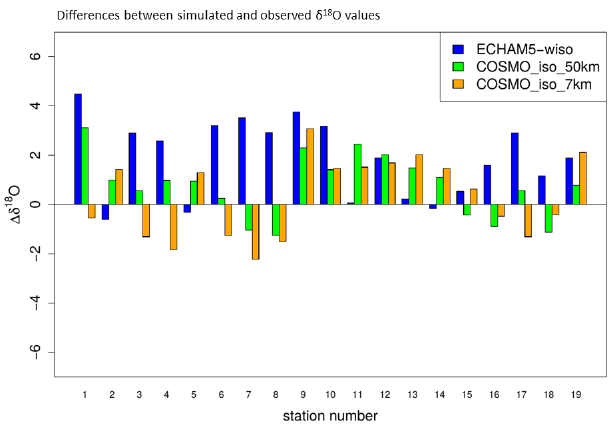
Figure 4. Differences ( (cid:49) ) between simulated and observed δ 18 O values (model minus observation) for the model results of ECHAM5-wiso, COSMO_iso_50km, and COSMO_iso_7km and snow pit samples and top core samples from ice cores from Greenland (averaging periods: COSMO_iso_50km: 2008–2014; COSMO_iso_7km: 2011; observation: 1940–2014). Numbers refer to the different snow pit locations shown in Fig. 3.